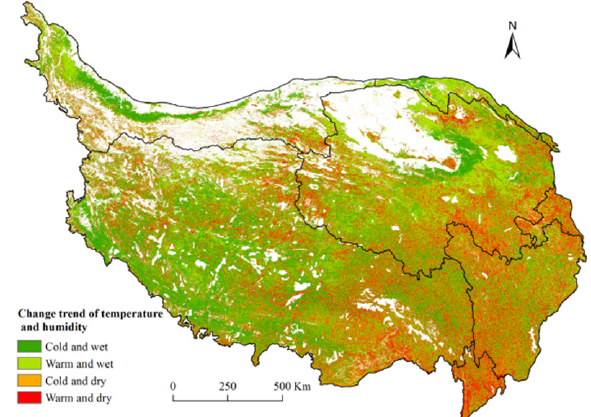
Figure 10. Temperature and precipitation trends on the Qinghai–Tibet Plateau.